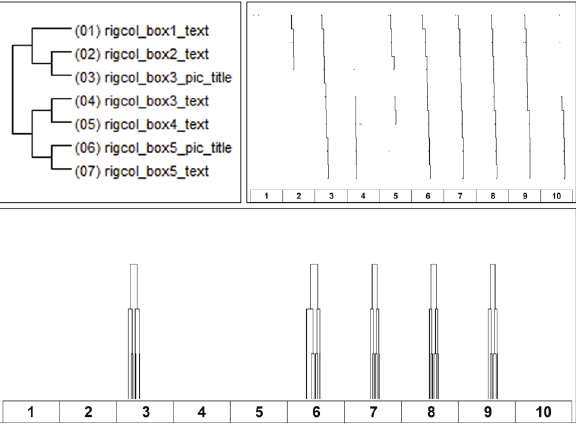
Figure 8. T-pattern diagram of pattern visualized in Figure 7; pattern structure in upper left, pattern occurrences in upper right and bottom, presentation positions at bottom of